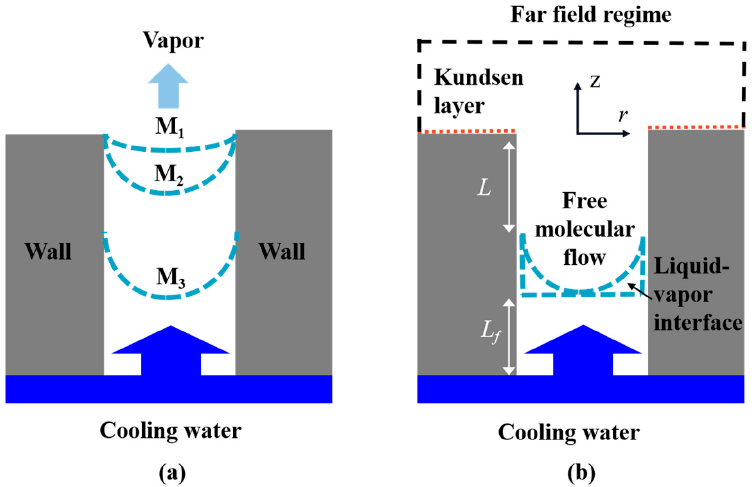
Figure 9. Evaporation process from a nanopore: ( a ) three shapes of the liquid-vapor interface; ( b ) the vapor transfer track.